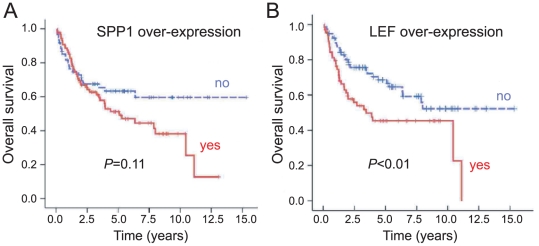
Kaplan-Meier overall survival curves based on (A) SPP1 overexpression (log rank p = 0.11) or (B) LEF1 overexpression (log rank p<0.01).